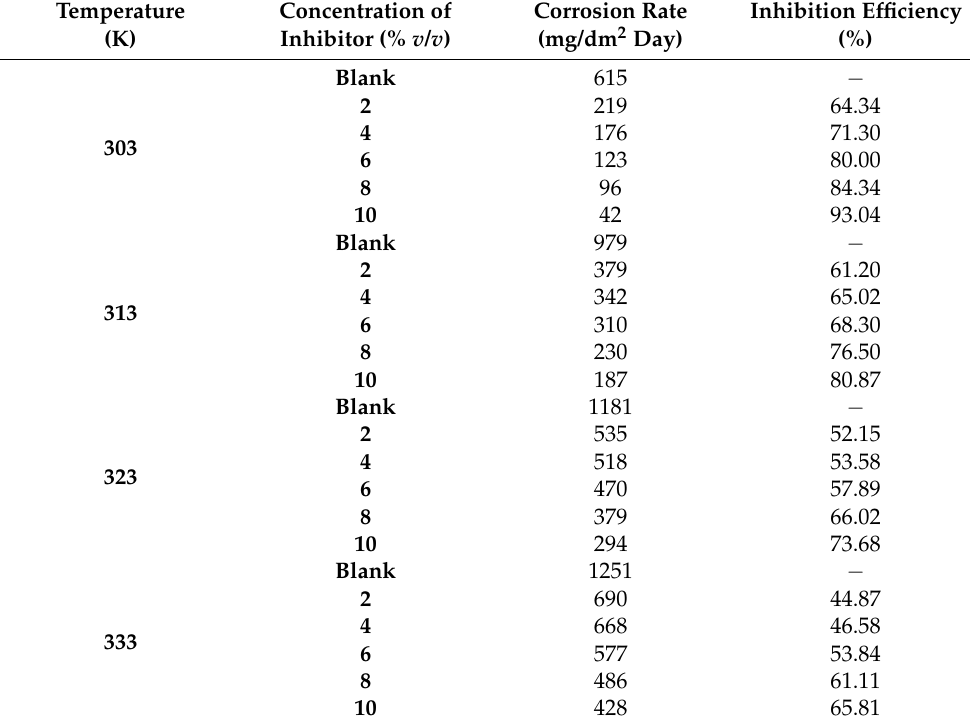
Table 4. Inhibition efficiency of SA-LE on the corrosion of mild steel in 1.0 M HCl at different